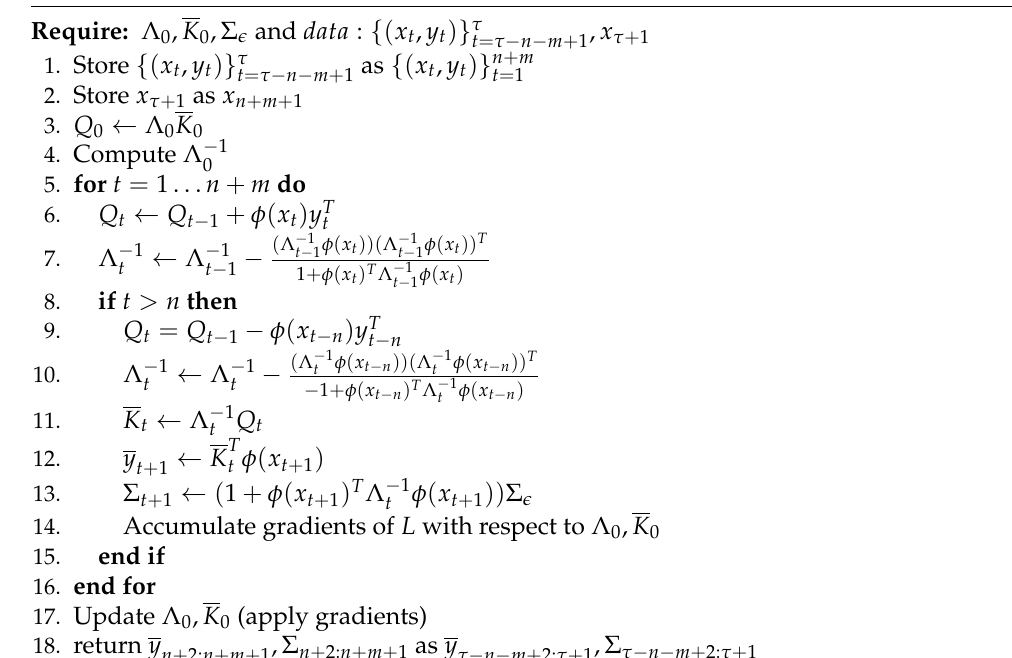
Algorithm 1 One cycle of the CORAL